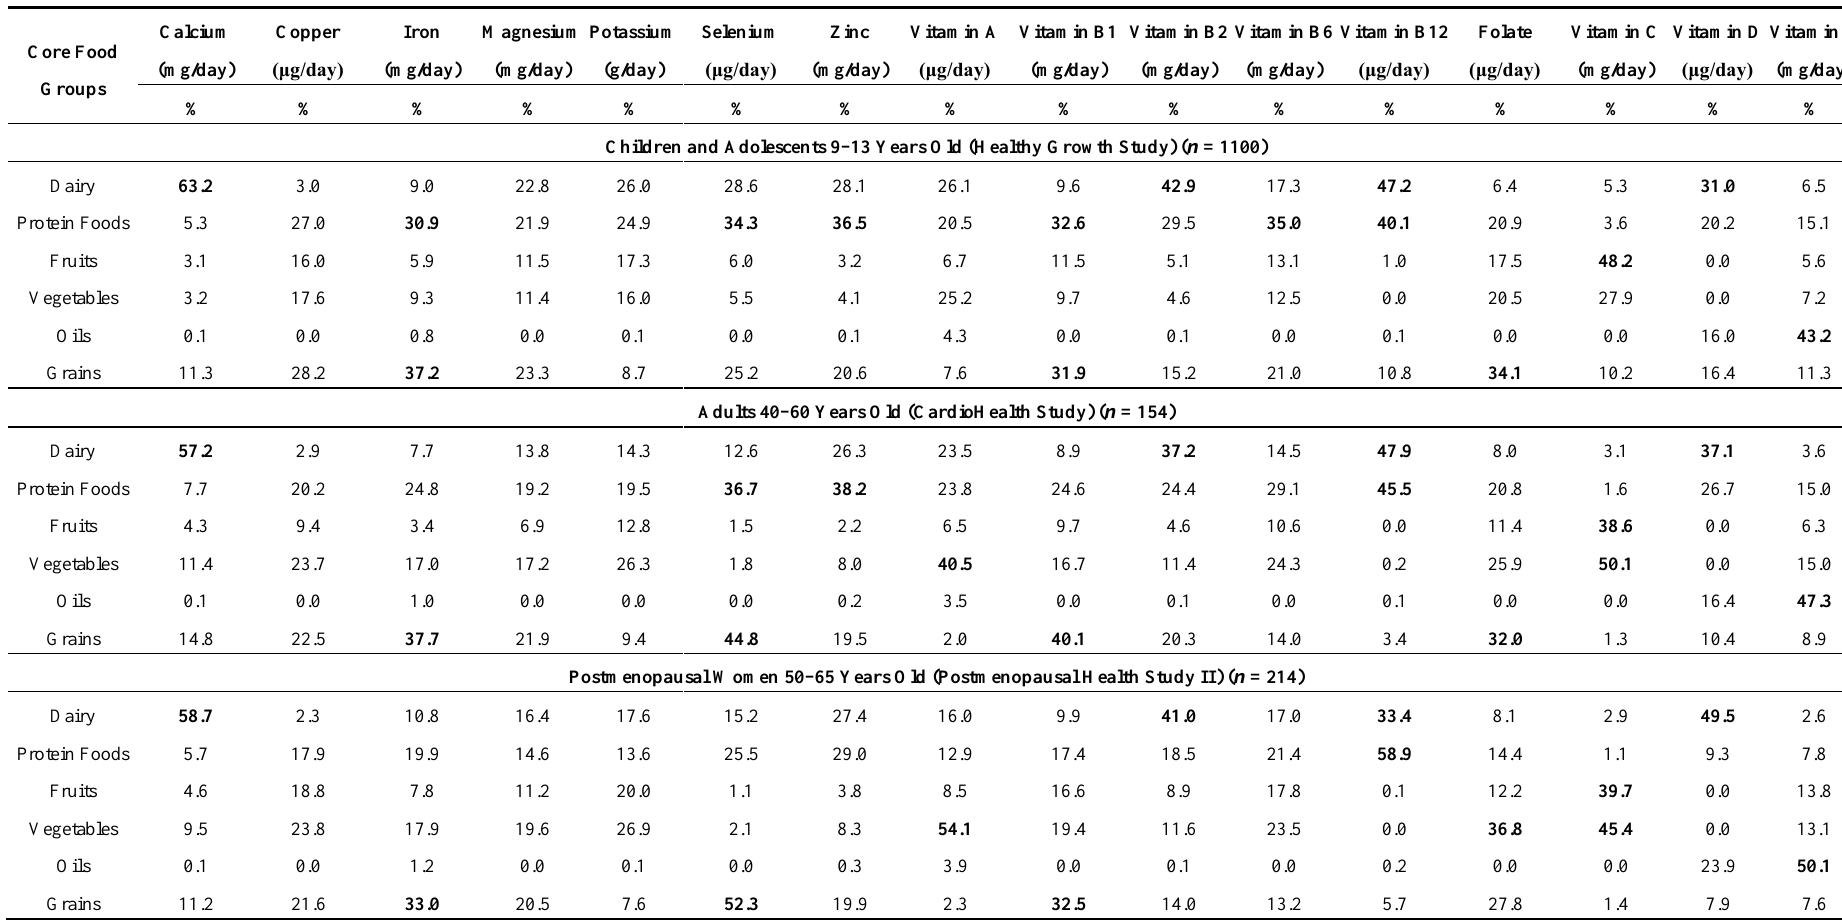
Table 3. Percent contribution of core food groups in the total dietary intake of micronutrients by children, middle-aged adults and postmenopausal women in